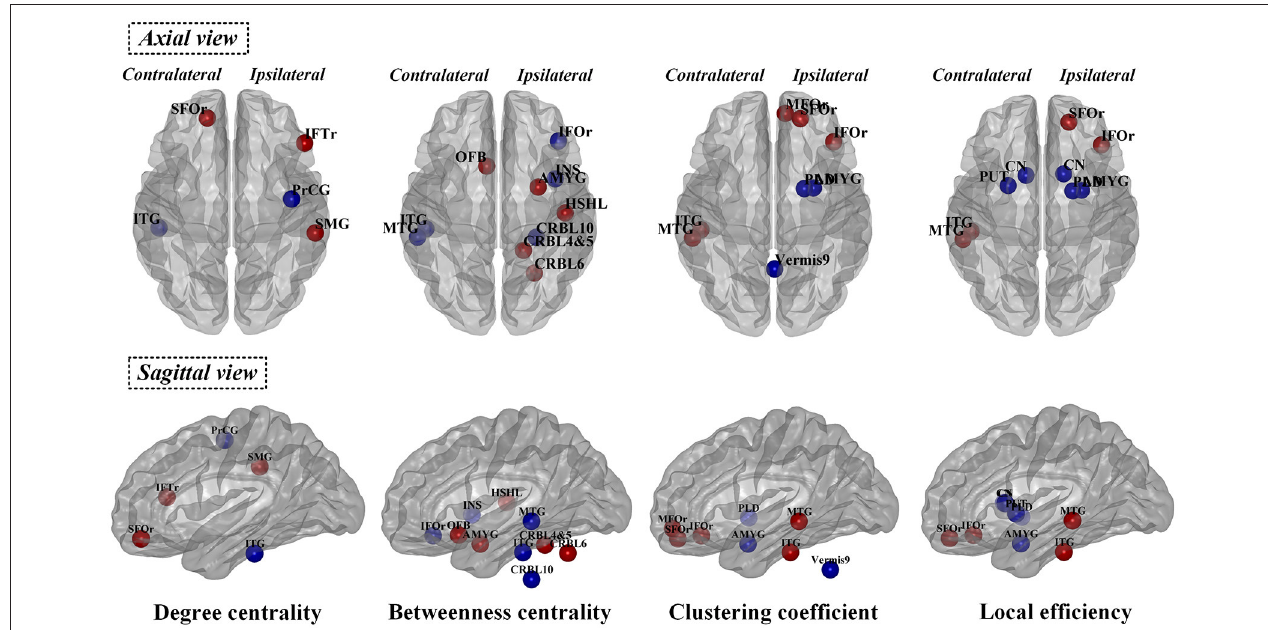
FIGURE 5 | Significant differences of normalized nodal properties including betweenness centrality, degree centrality, clustering coefficient and local efficiency between PD patients with hemiparkinsonism and normal controls. Both axial view and sagittal view were shown. Red color showed the increased nodal values in patient group and blue color showed the decreased nodal values in patient group compared with normal controls. SFOr, superior orbitofrontal gyrus; IFTr, triangular part of inferior frontal gryus; MFOr, middle orbitofrontal gryus; SFOr, superior orbitofrontal gyrus; IFOr, inferior orbitofrontal gryus; OFB, olfactory gyrus; PrCG, precentral gyrus; MTG, middle temporal gyrus; ITG, inferior temporal gyrus; CN, caudate nucleus; PUT, putamen; PLD, pallidum; AMYG, amygdala; INS, insula; HSHL, Heschel’s gyrus; SMG, supramarginal gryus; CRBL,